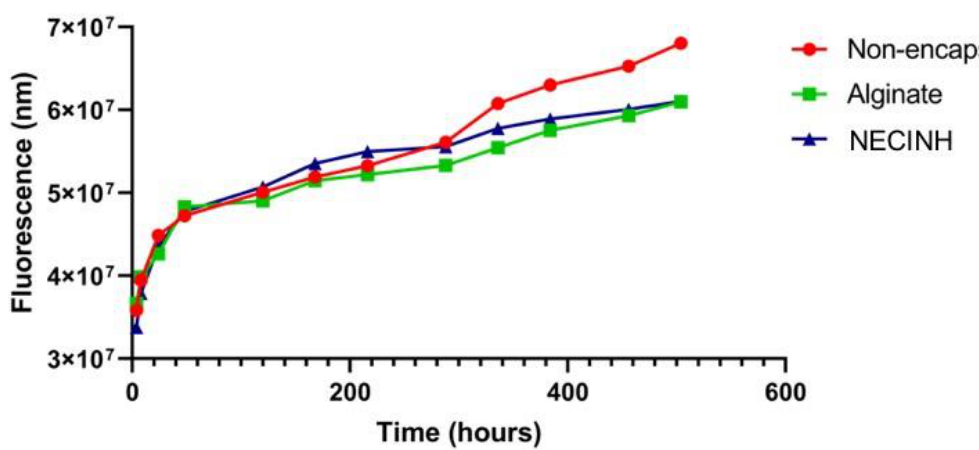
Figure 2. Impact of testicular fragment incorporation in NECINH nanoparticles-loaded alginate hydrogel on tissue necrosis when cultured in hypoxia. Cumulative values of fluorescence corresponding to the lactate dehydrogenase (LDH) measured in culture supernatants recovered every 48–72 h. We analyzed 2484 seminiferous tubule sections (STs), of which 1371 at 5 days (437 for non-encapsulated, 371 for encapsulation in alginate, and 563 for encapsulation in alginate with